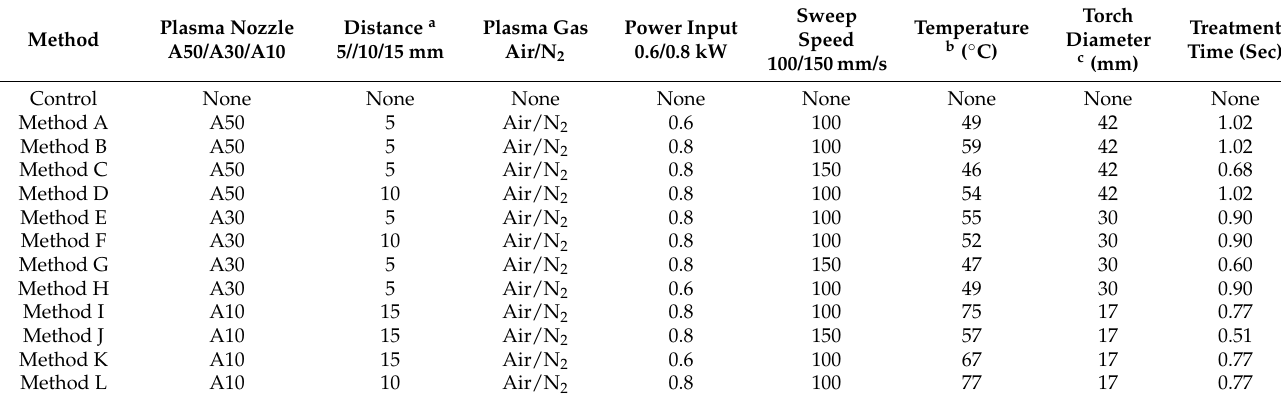
Table 1. Parameters of the NTP-treated djulis seed in this